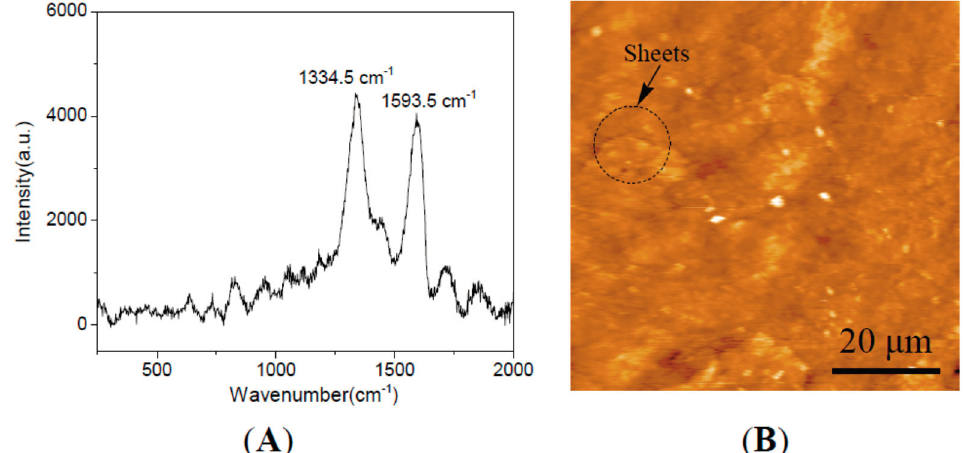
Figure 1. ( A ) Raman spectra; and ( B ) AFM of GNS-based epoxy resin